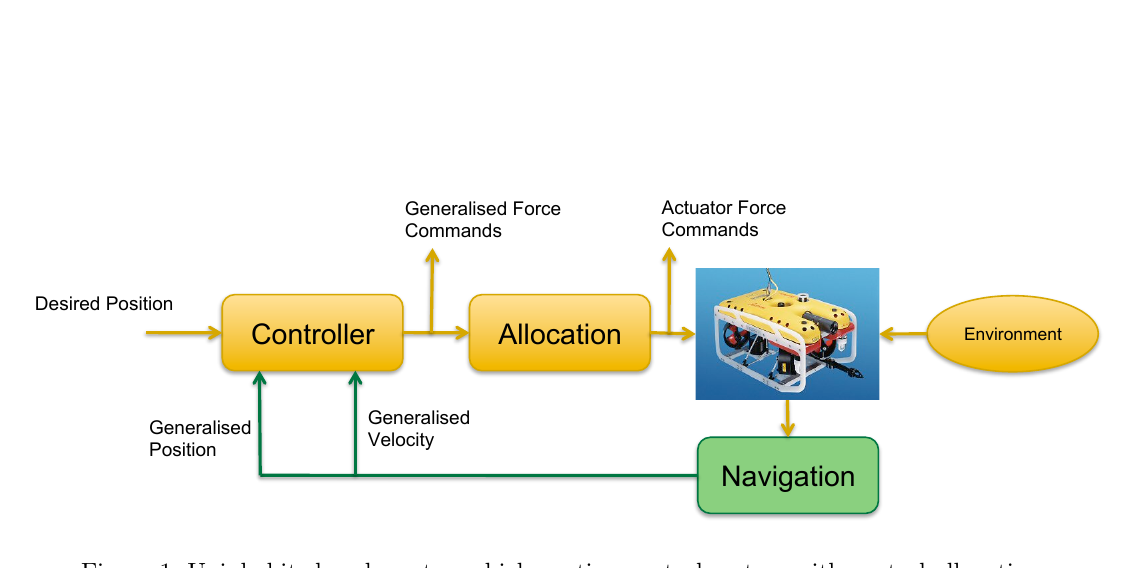
Figure 1: Uninhabited underwater vehicle motion control system with control allocation.